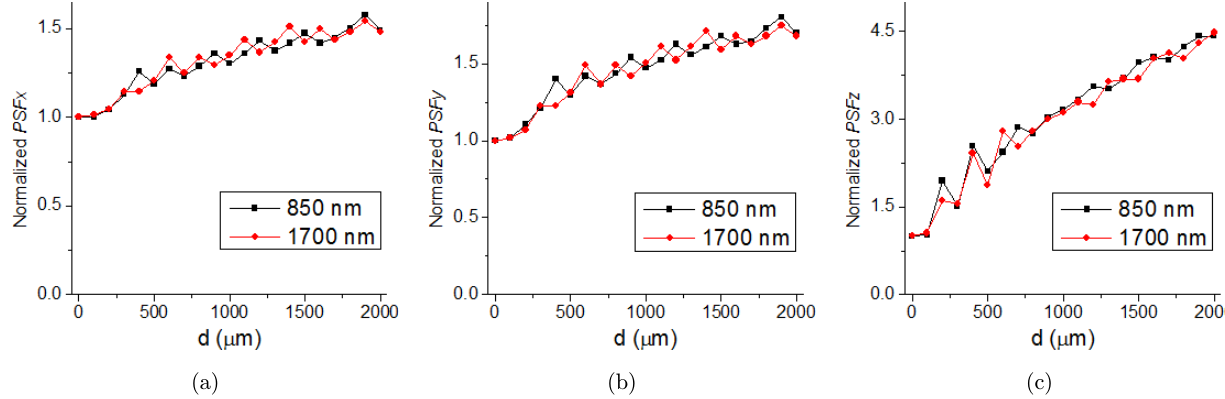
Fig. 4. Normalized two-photon (a) PSF x , (b) PSF y and (c) PSF z vs imaging depth for 850-nm and 1700-nm excitations. All PSFs were normalized to those at the surface ( d ¼ 0). Also NA ¼ 1 : 05 and n 1 ¼ 1 : 33; (cid:2) n ¼ 0 : 03 for 850-nm excitation and (cid:2) n ¼ 0 : 06 for 1700-nm